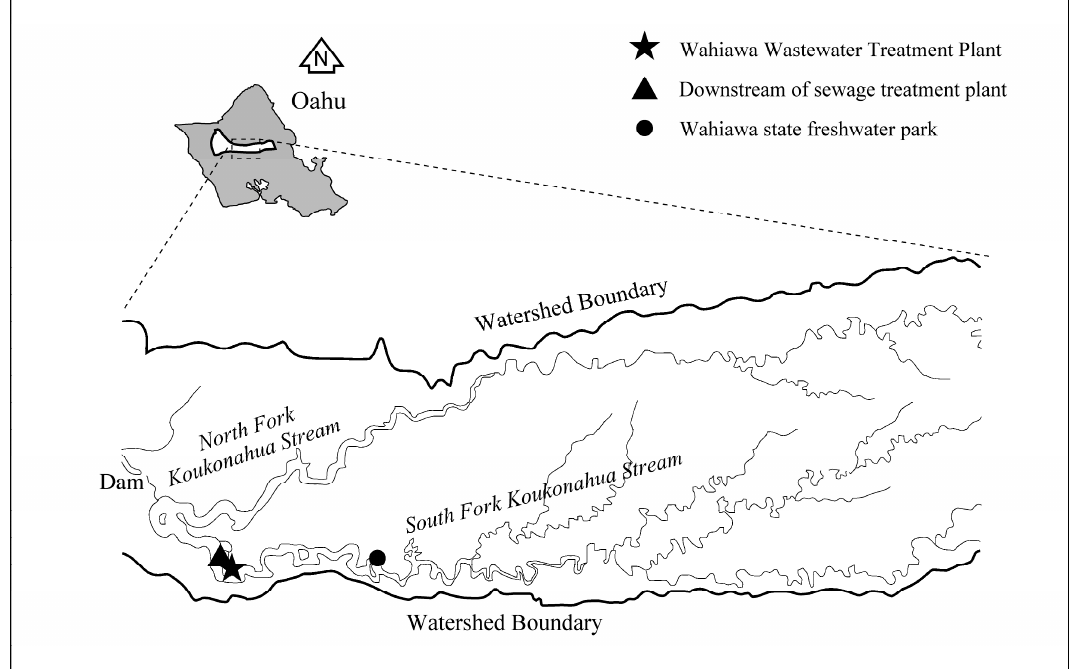
Figure 1. Lake Wilson on Central Oahu, Hawaii, and the locations of two sampling station.